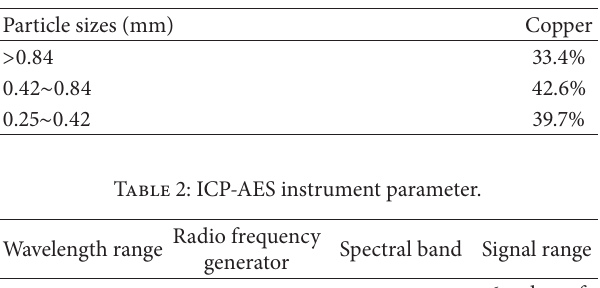
Table 1: Concentration of copper in three particle sizes in crushed flexible PCB.